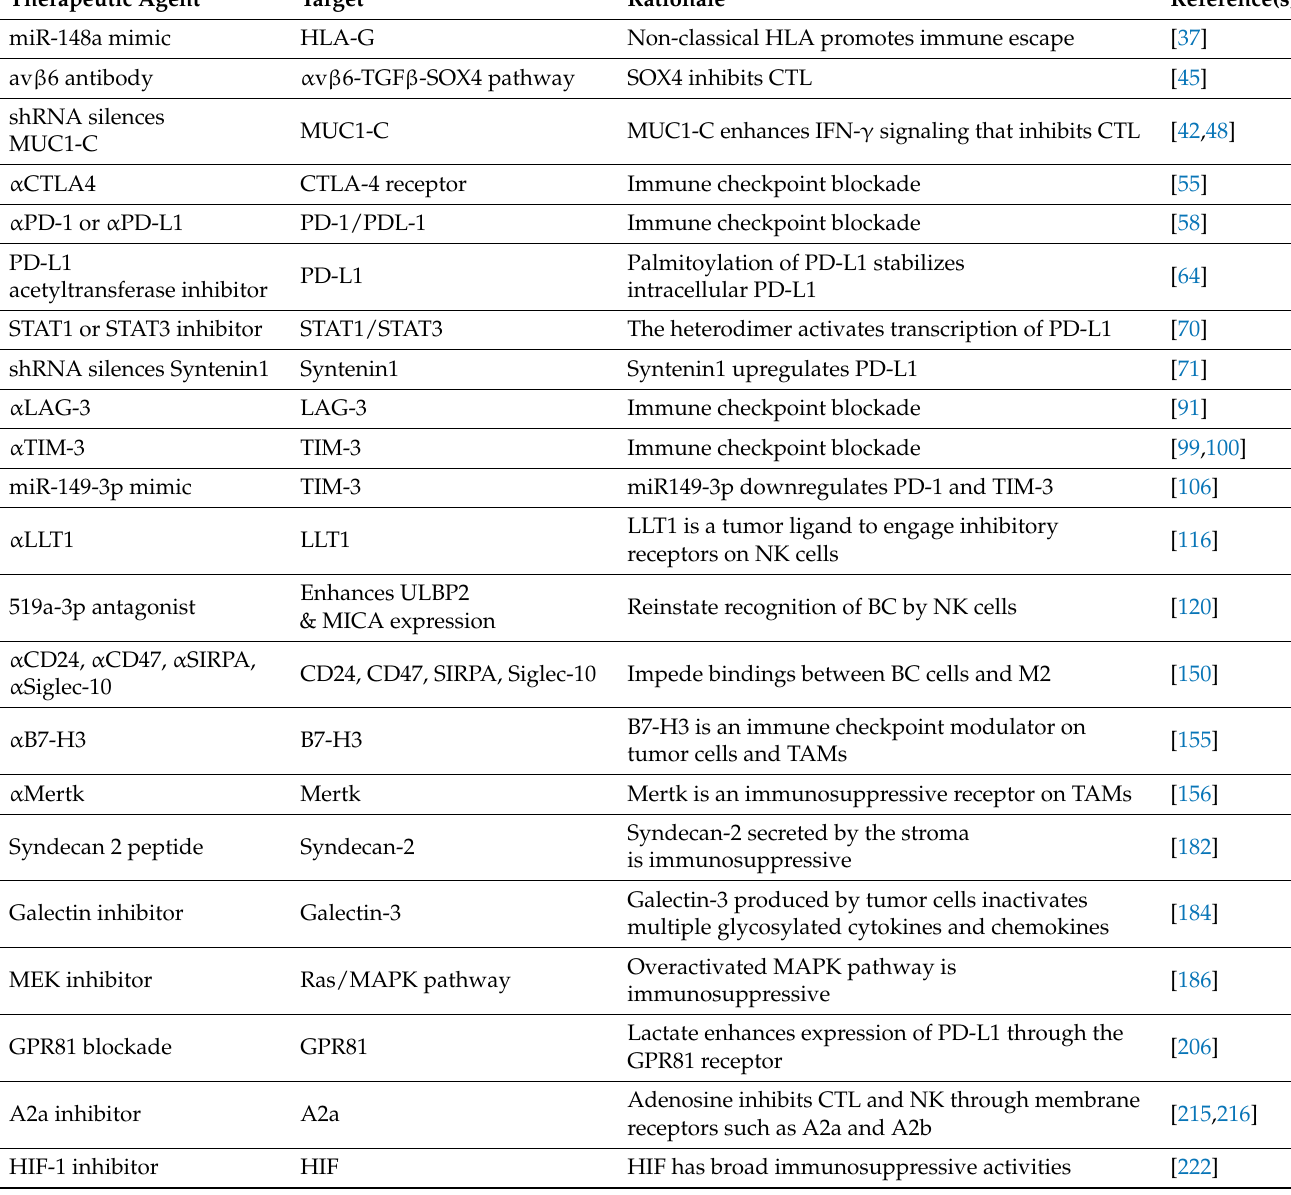
Table 1. Representative therapeutic targets combat immune evasion of breast